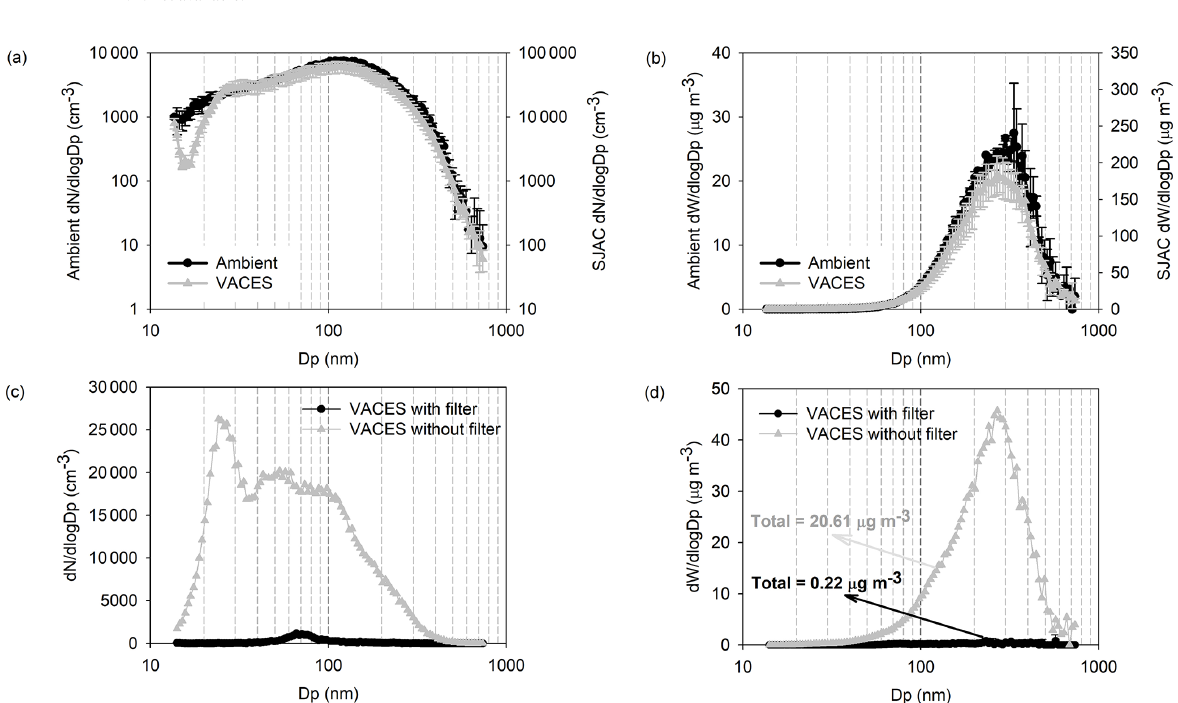
Figure 3. Particle (a, c) number and (b, d) mass size distribution in ambient and VACES systems. The error bar is standard deviation of three parallel